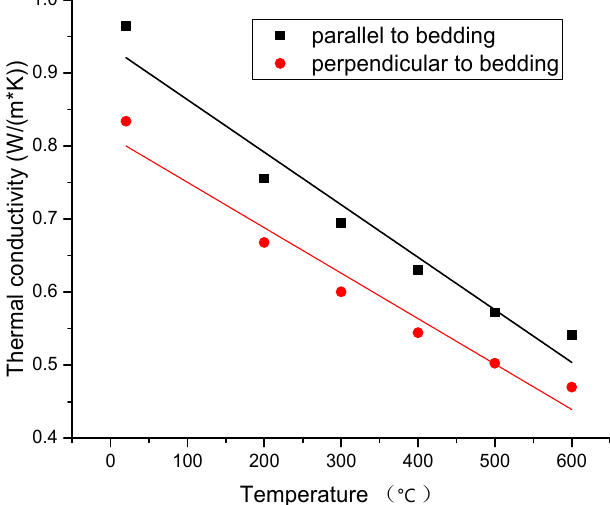
Figure 8. Variation of heat conductivity with temperature.